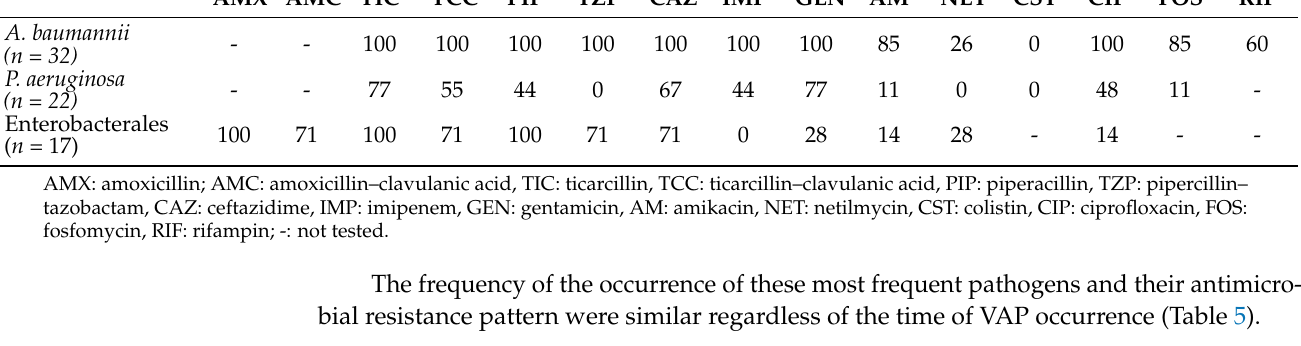
Table 5. Antibacterial resistance pattern of A. baumannii , P. aeruginosa , Enterobacterales.